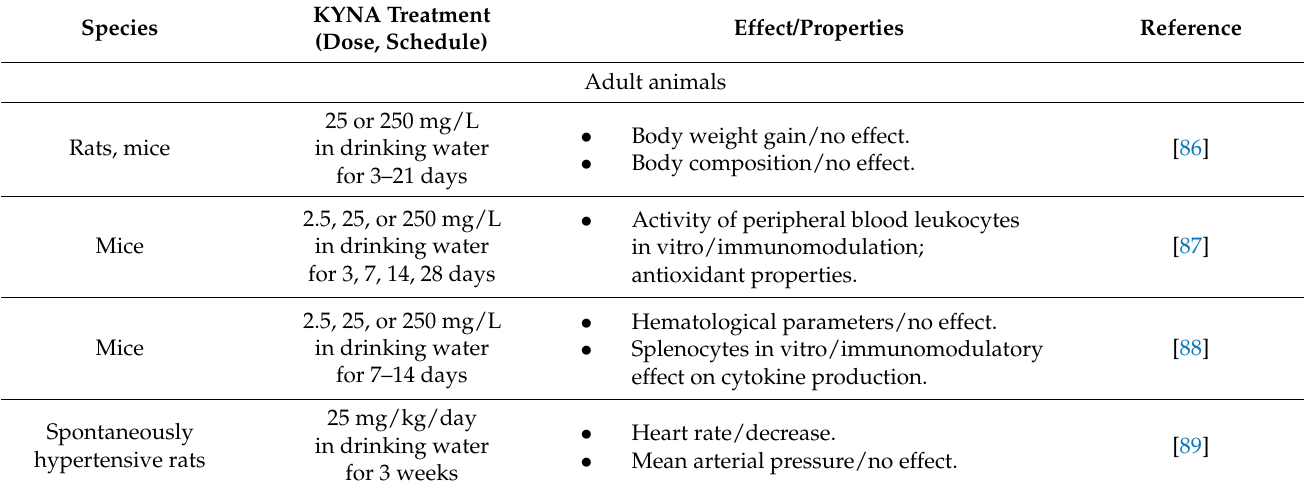
Table 2. Consequences of kynurenic acid (KYNA) dietary supplementation in rodents.